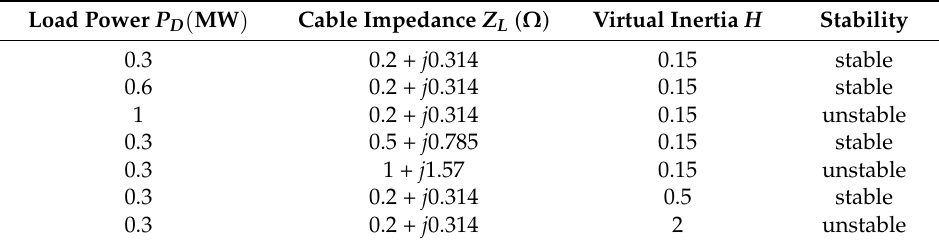
Table 3. Stability of the VSG-IIDG with different P D , Z L , and H.